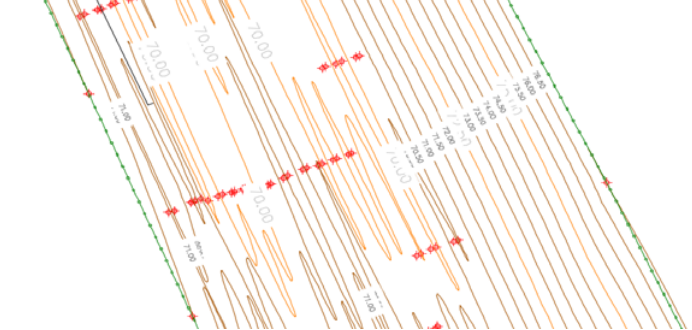
Figure 28 – Model display via contour lines - equidistance 0.5